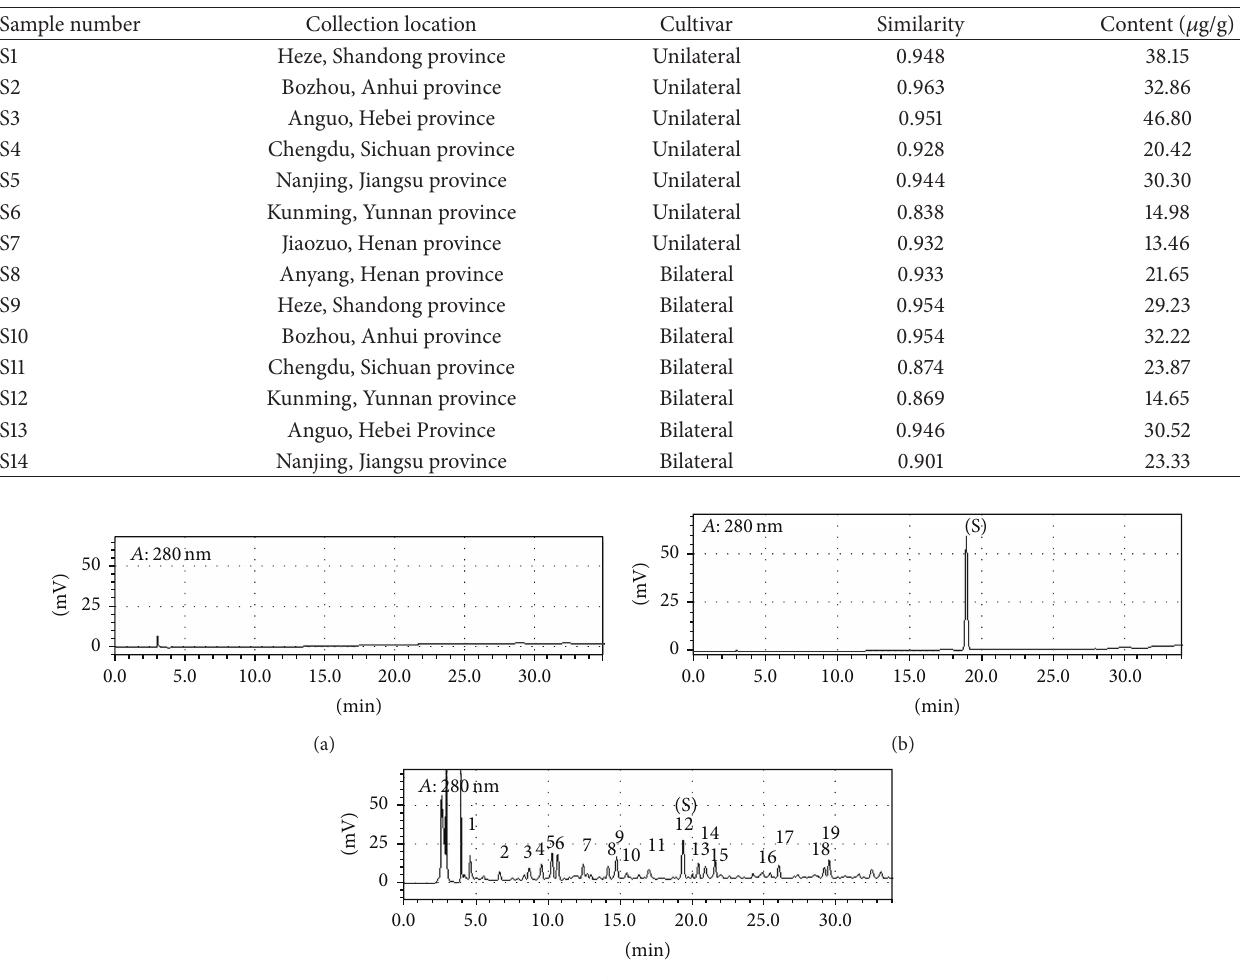
Table 1: Similarities in isovanillin content in 14 batches of Benincasa hispida seeds.